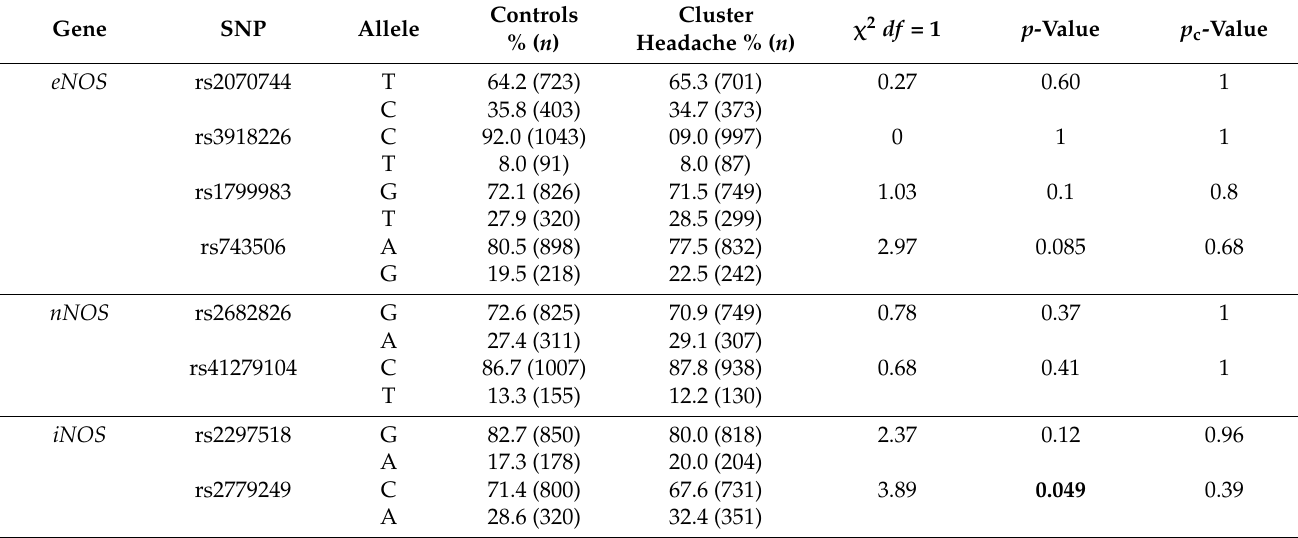
Table 2. Results from the allele analysis for eight variants in endothelial nitric oxide synthase ( eNOS ), neuronal NOS ( nNOS ) and inducible NOS ( iNOS